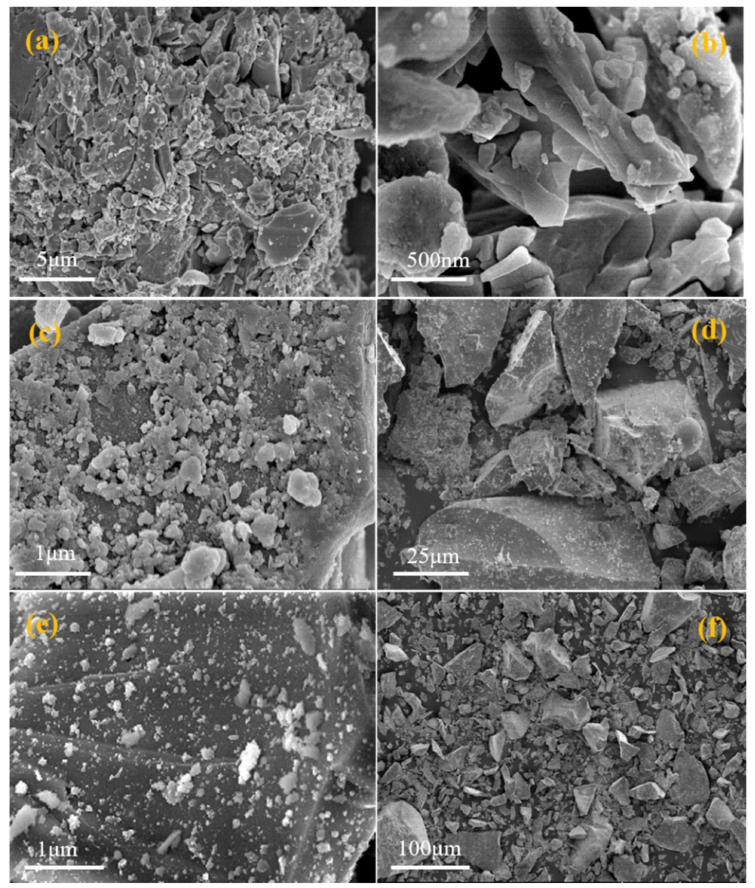
Figure 3. SEM morphology of phosphorous slag: ( a – f ) typical SEM images of phosphorous slag under different